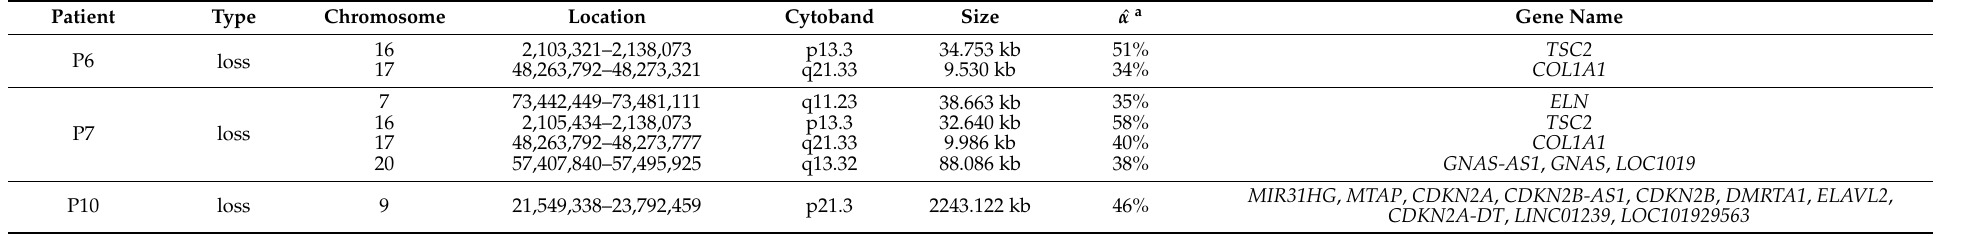
Table 2. List of losses in adenoma tissues of patients P6, P7, and P10 (second group).